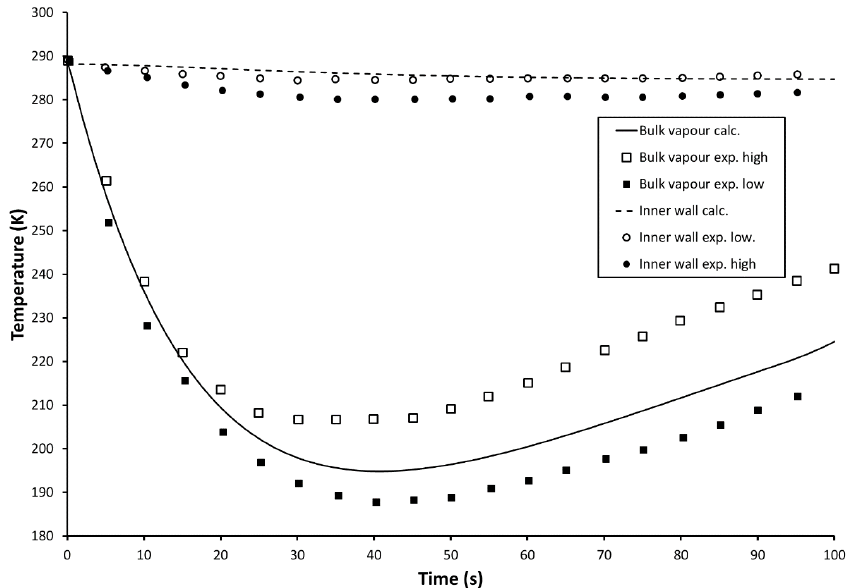
Figure 1. Comparison between simulated and experimental results for an N 2 -filled pressure vessel blowdown at ambient conditions.